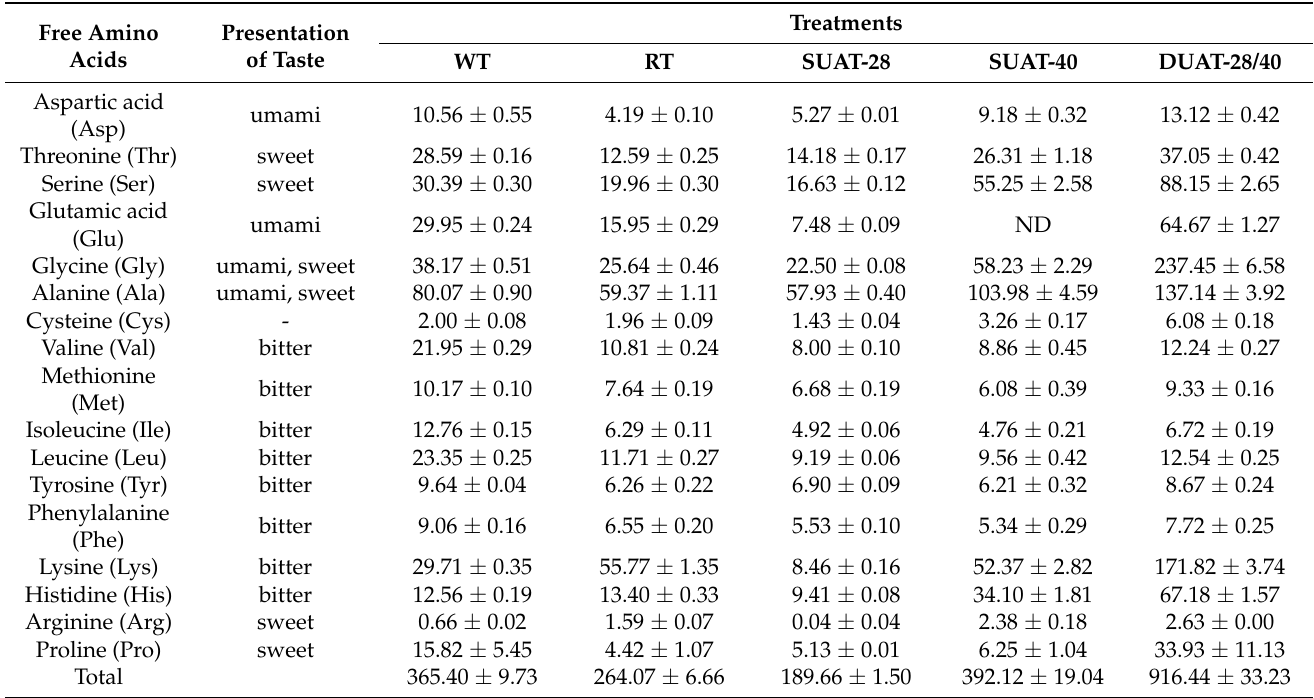
Table 3. Differences in free amino acids contents (mg/100 g) of large yellow croaker under different thawing